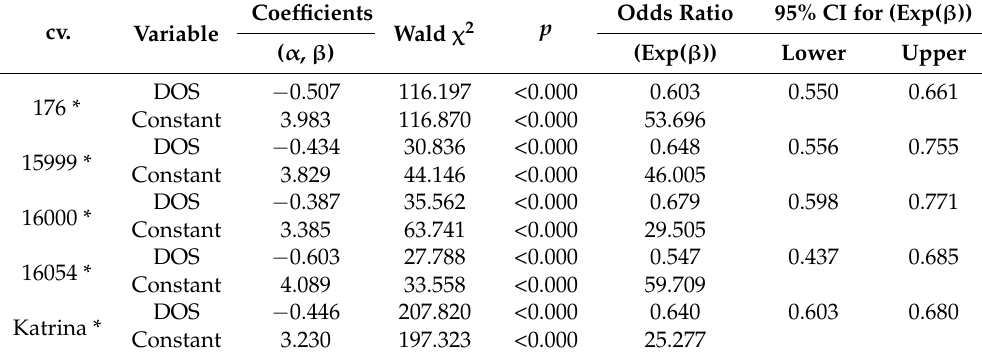
Table 9. Estimation of the independent simple logistic regression parameters for each mini-type cucumber cultivar as a function of postharvest FWL % as a factor influencing the probability of